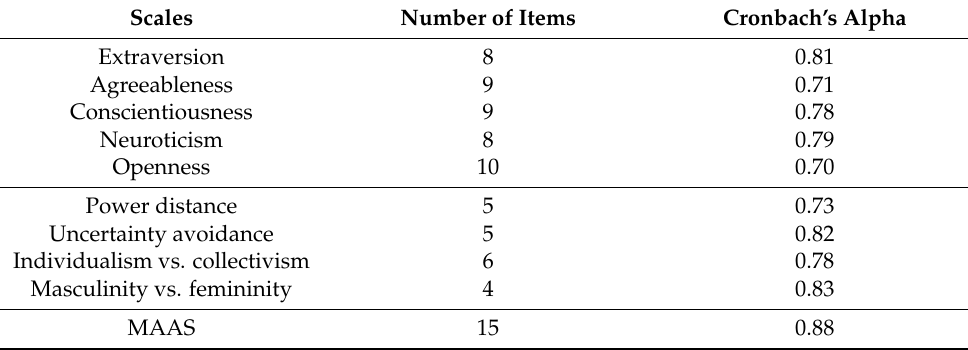
Table 5. Number of items and Cronbach alpha for all scales.